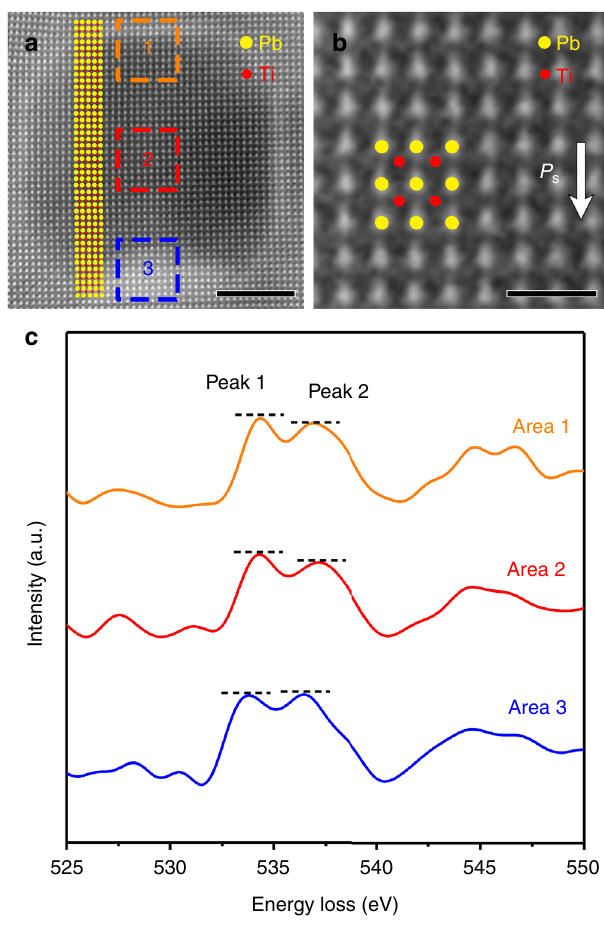
Fig. 3 High-resolution HAADF-STEM and EELS characterization of the microregion near a single mesopore. a High-resolution HAADF-STEM image of a typical mesopore of mesoporous PTO fi bers. Scale bar, 5nm. b Zoom-in image corresponding to area 2 in a . Scale bar, 2 nm. The positions of Pb and Ti atoms were marked in the image using yellow and red dots,